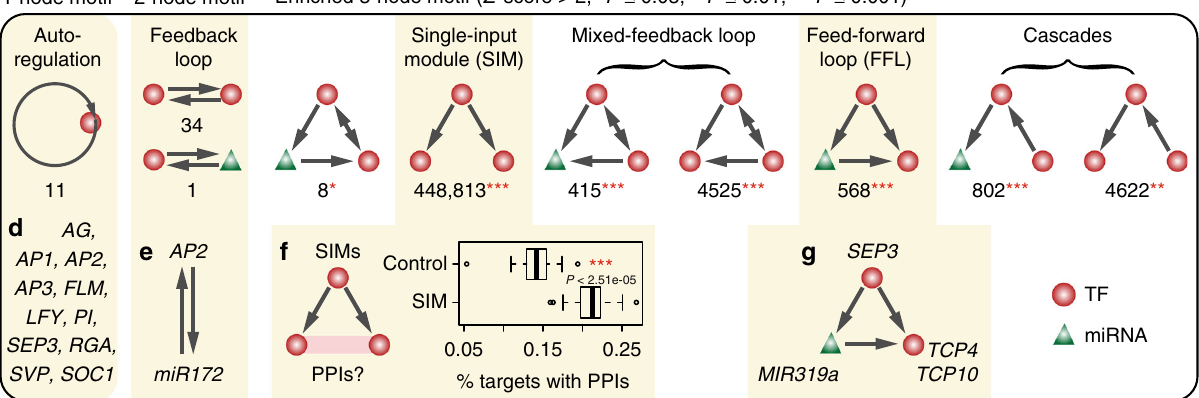
Fig. 3 Characterizing fl owering gene regulatory networks and motifs. a Hive plot showing gene regulatory networks involved in fl oral regulators, miRNA genes, and transcription factors (TFs). Connections indicate potential regulation relationships. Regulator-miRNAs and regulator-TFs relationships